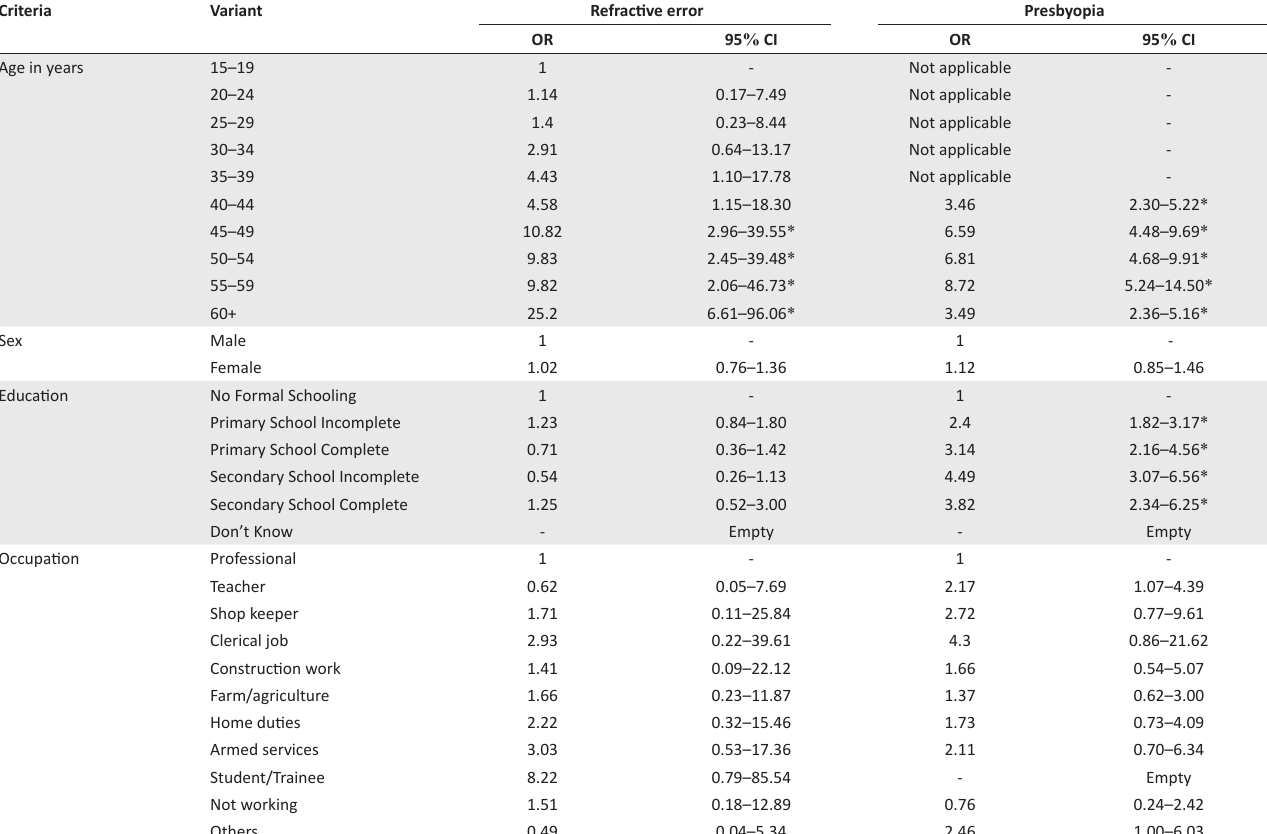
TABLE 3: Odds ratios of age, sex, education and occupation with refractive error and presbyopia. Criteria